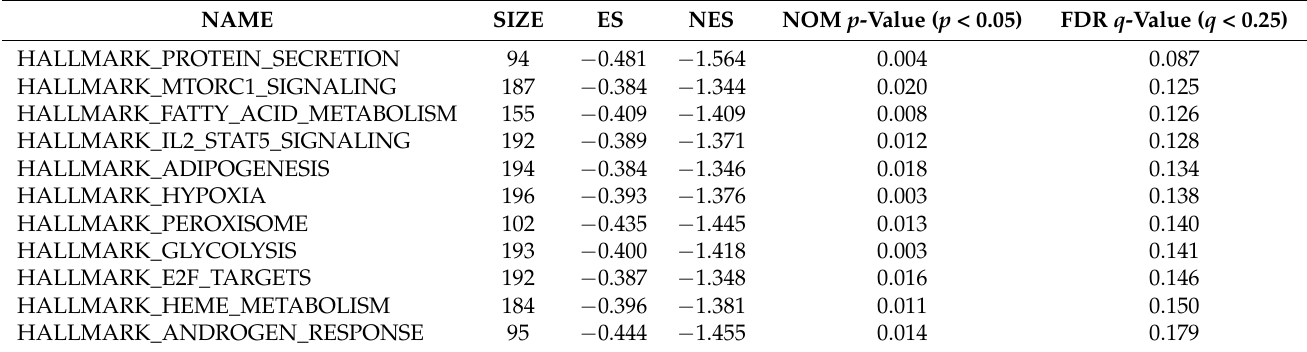
Table 1. Gene sets enriched in the transcriptome of RU-486 treated